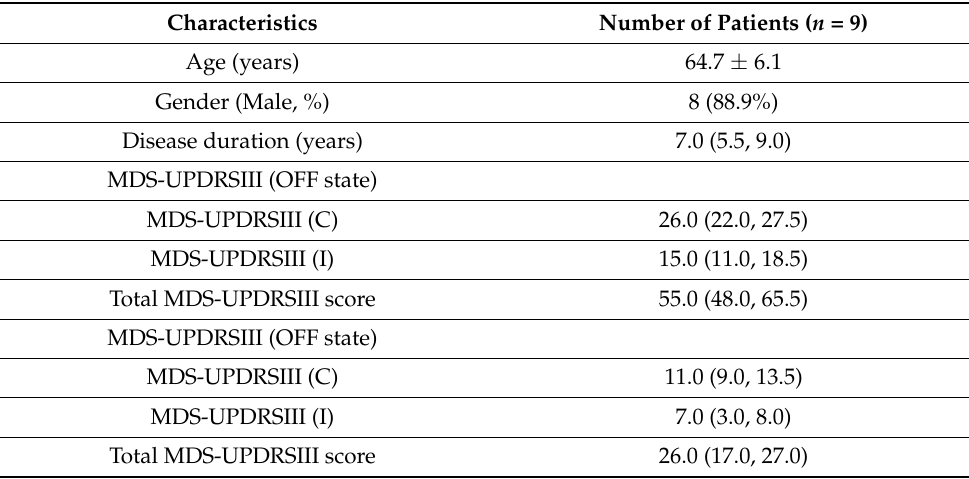
Table 1. Baseline characteristics of the